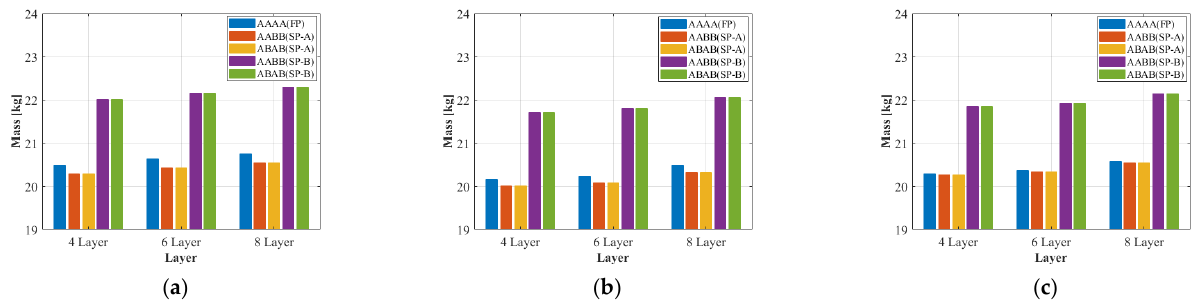
Figure 14. Comparison of the total mass of the baseline designs as a function of SPP, layer, phase arrangements, and winding layout: ( a ) SPP = 2; ( b ) SPP = 3; ( c ) SPP = 4.